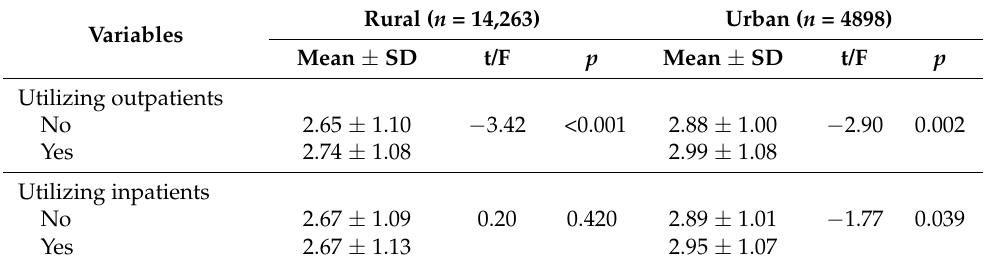
Table 3. Distribution of degree of dissatisfaction with local medical